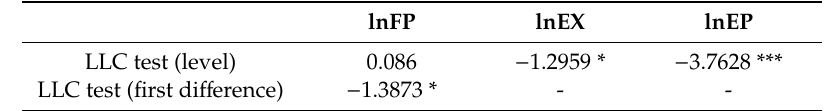
Table 2. Unit root test results.